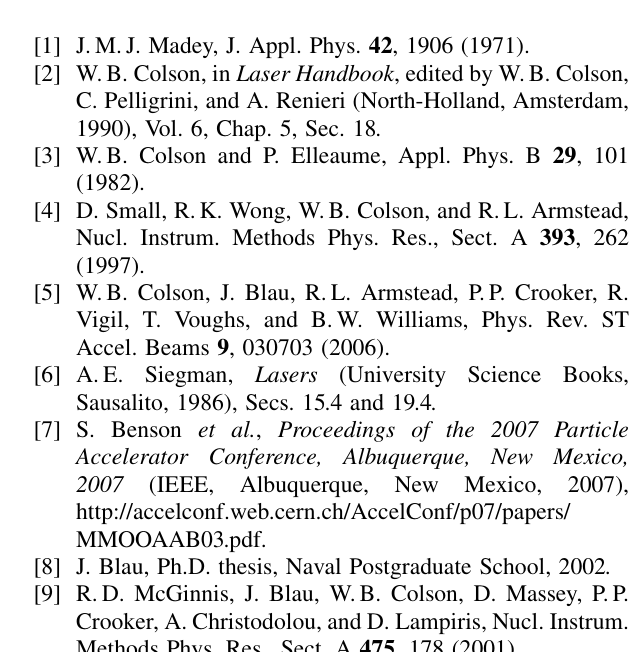
FIG. 9. Electron beam shift at HWHM gain versus z 0 .